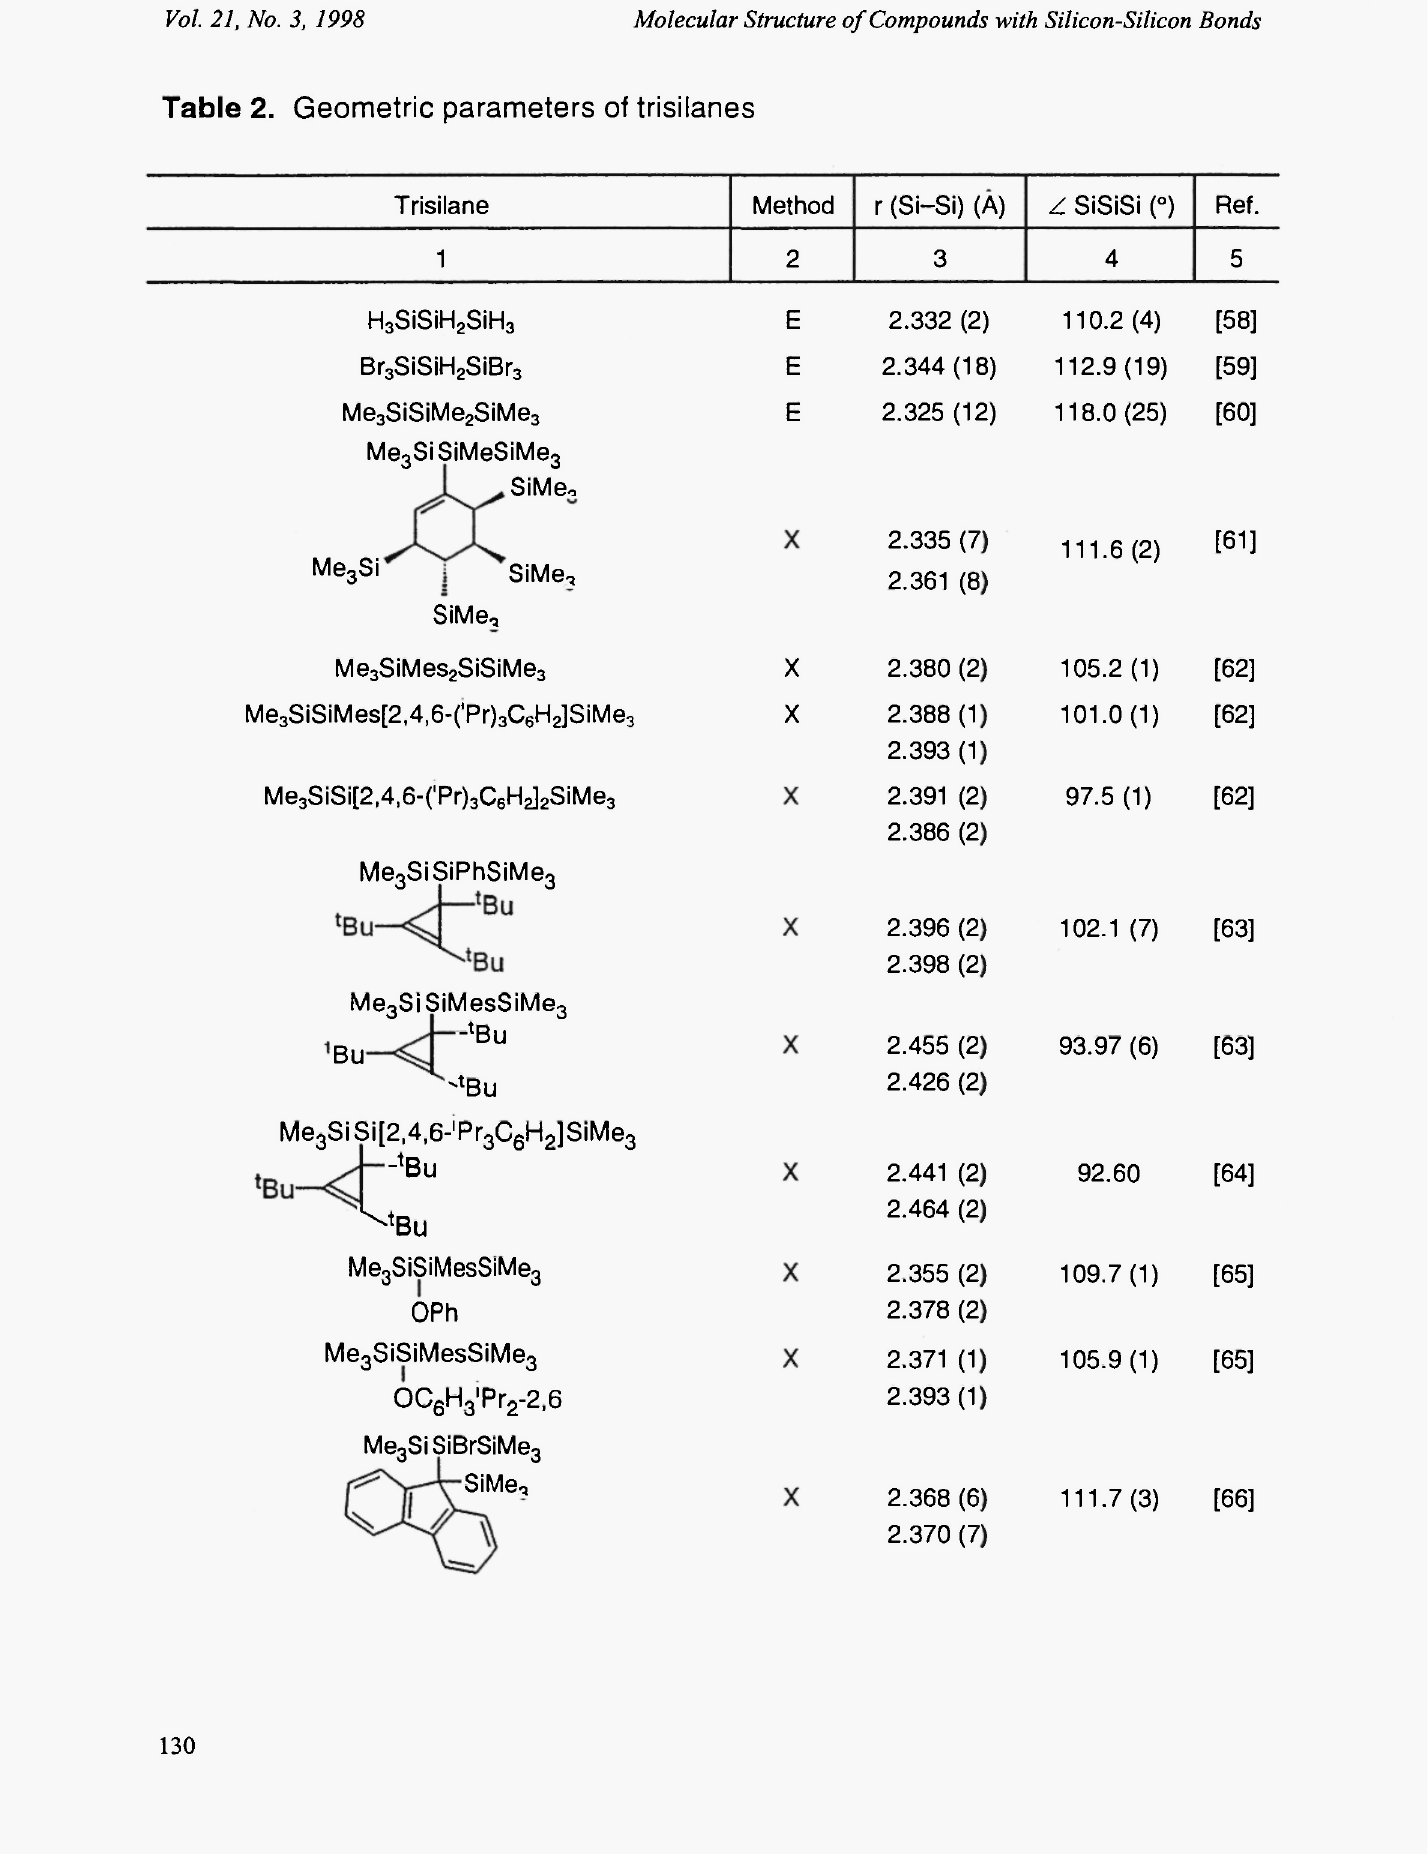
Table 2. Geometric parameters of trisilanes